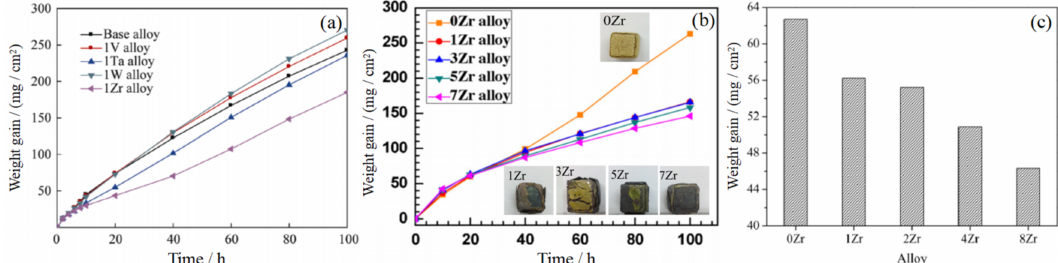
Figure 7. Weight gain versus time for Nb-Si-based alloys oxidized at 1250 ◦ C for 100 h ( a ). Oxidation weight gain curve ( b ) and oxidation weight gain histogram ( c ) of Nb-Si-based alloys with different Zr contents. Copyright 2017 Springer Nature, 2019 Elsevier and 2017 Elsevier.